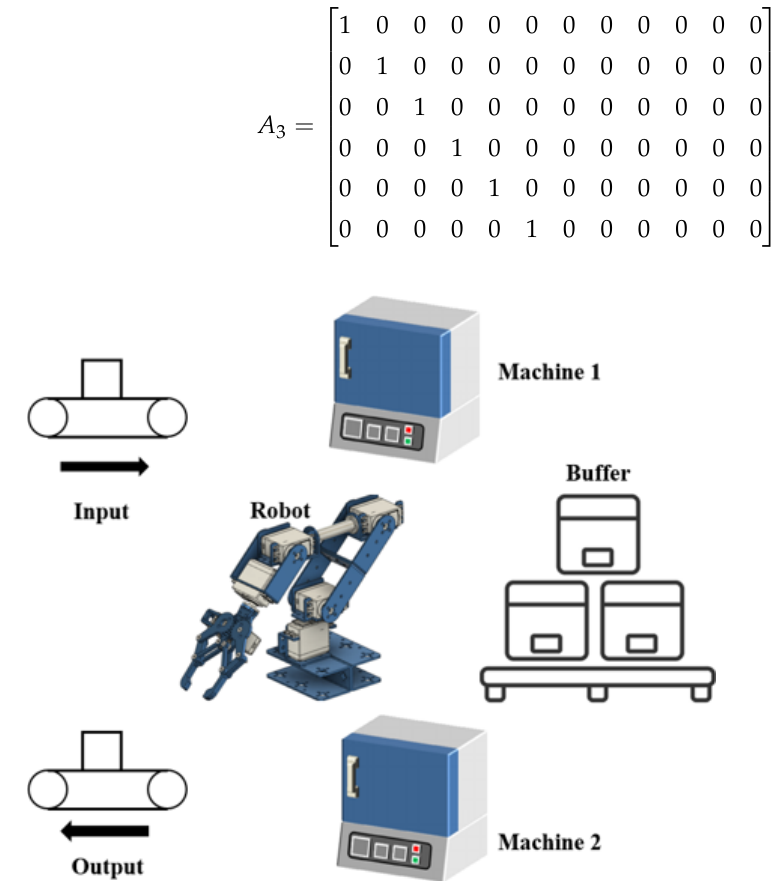
Figure 8. A small flexible manufacturing cell.